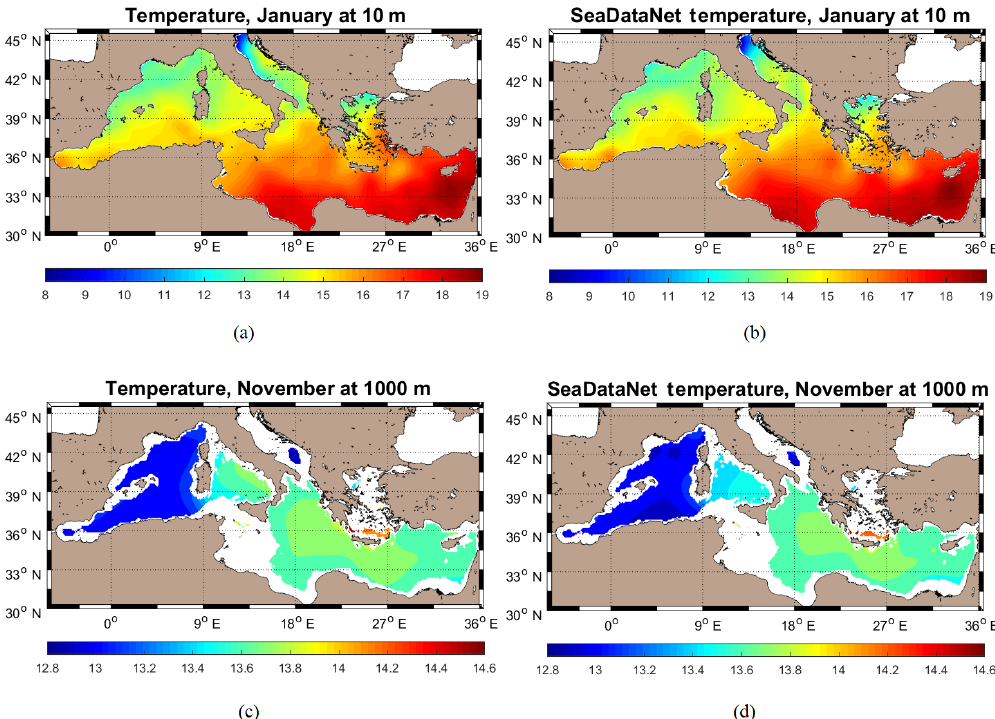
Figure 9. Comparison of atlas temperature (a, c) and SeaDataNet climatology (b, d) between January at 10m (a, b) and November at 1000m (c, d)